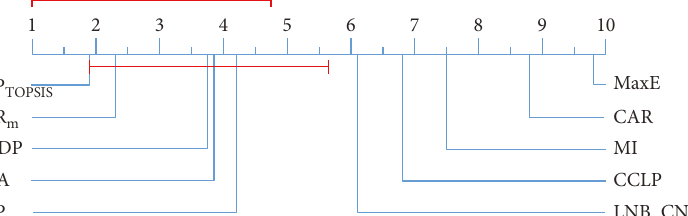
Figure 4: Comparison of LP against the others with the Bonferroni-Dunn test. This comparison is based on the results in Table 3. All TOPSIS methods with ranks outside the marked interval are signi fi cantly di ff erent from LP